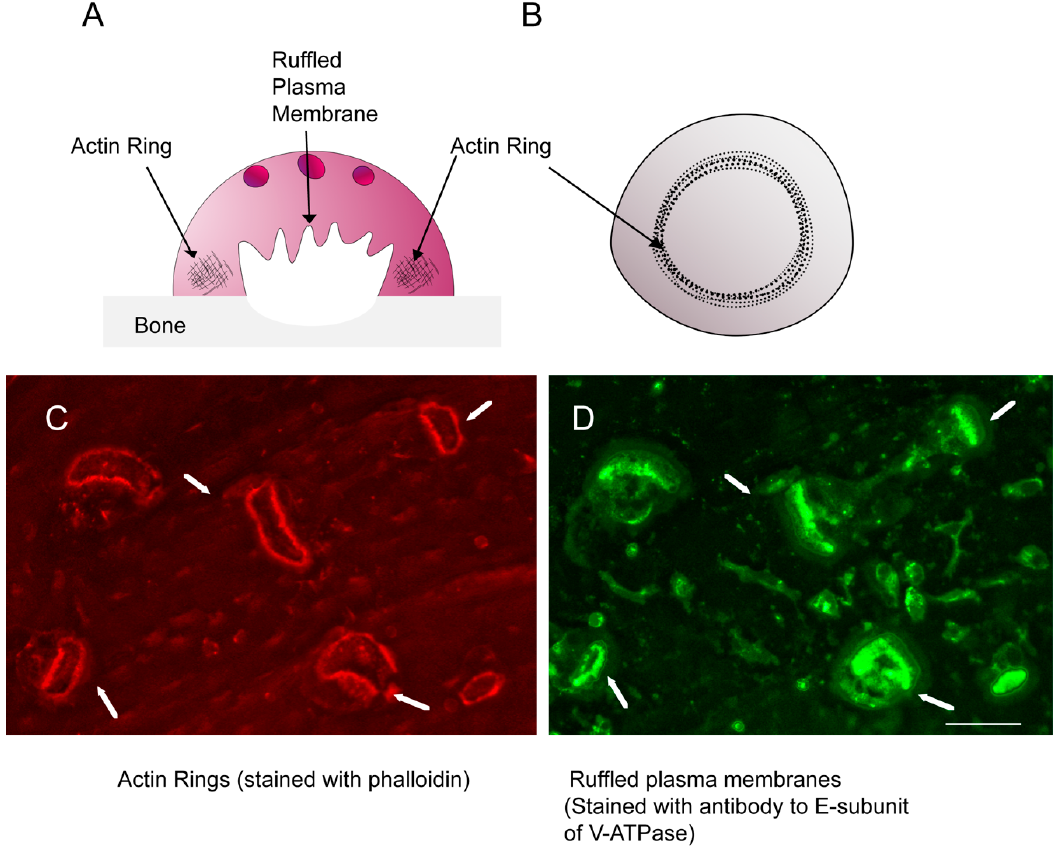
Figure 3. Osteoclasts are highly specialized cells that migrate through mineralized tissue. ( A ) A schematic of a resorbing osteoclast from the side. ( B ) Schematic of cell from side. ( C ) Immunofluorescence micrograph of actin rings stained with Texas Red-phalloidin (red). ( D ) Immunofluorescence micrograph of same cells stained with a rabbit polyclonal anti-E-subunit of V-ATPase antibody followed by an Alexa 488-tagged anti-rabbit IgG secondary antibody to detect ruffled plasma membranes (green). Arrows show examples of actin rings and ruffled membranes, with arrows pointing to same cells in the two panels. The scale bar for the micrographs is 25 μ m.